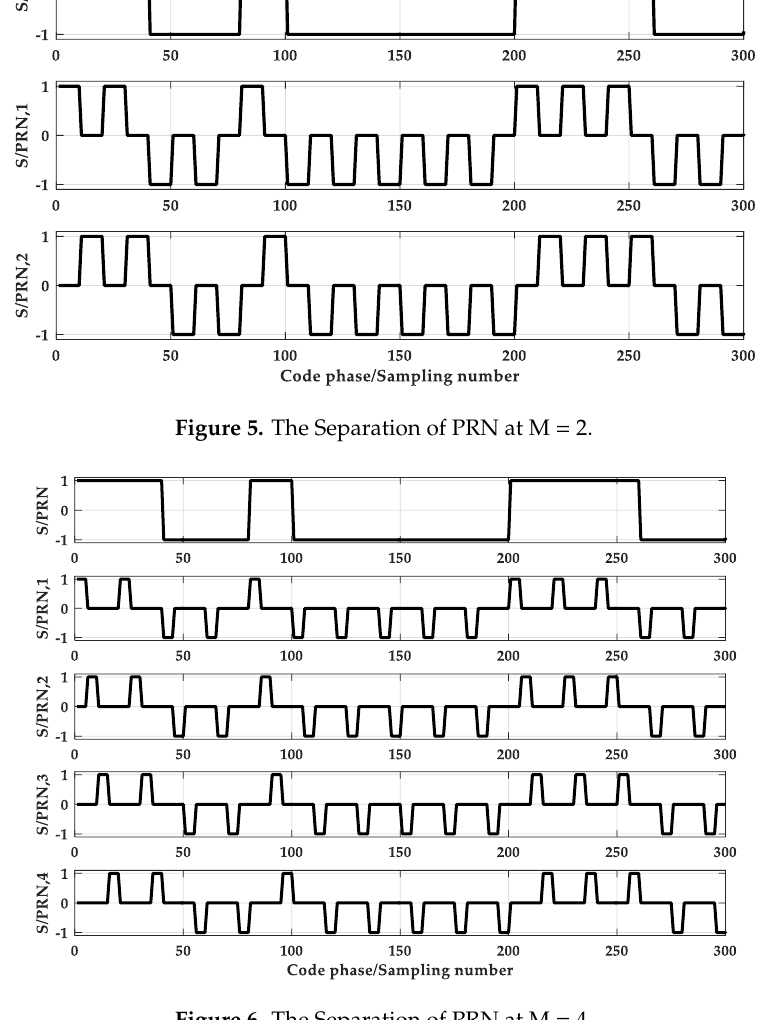
Figure 6. The Separation of PRN at M = 4.